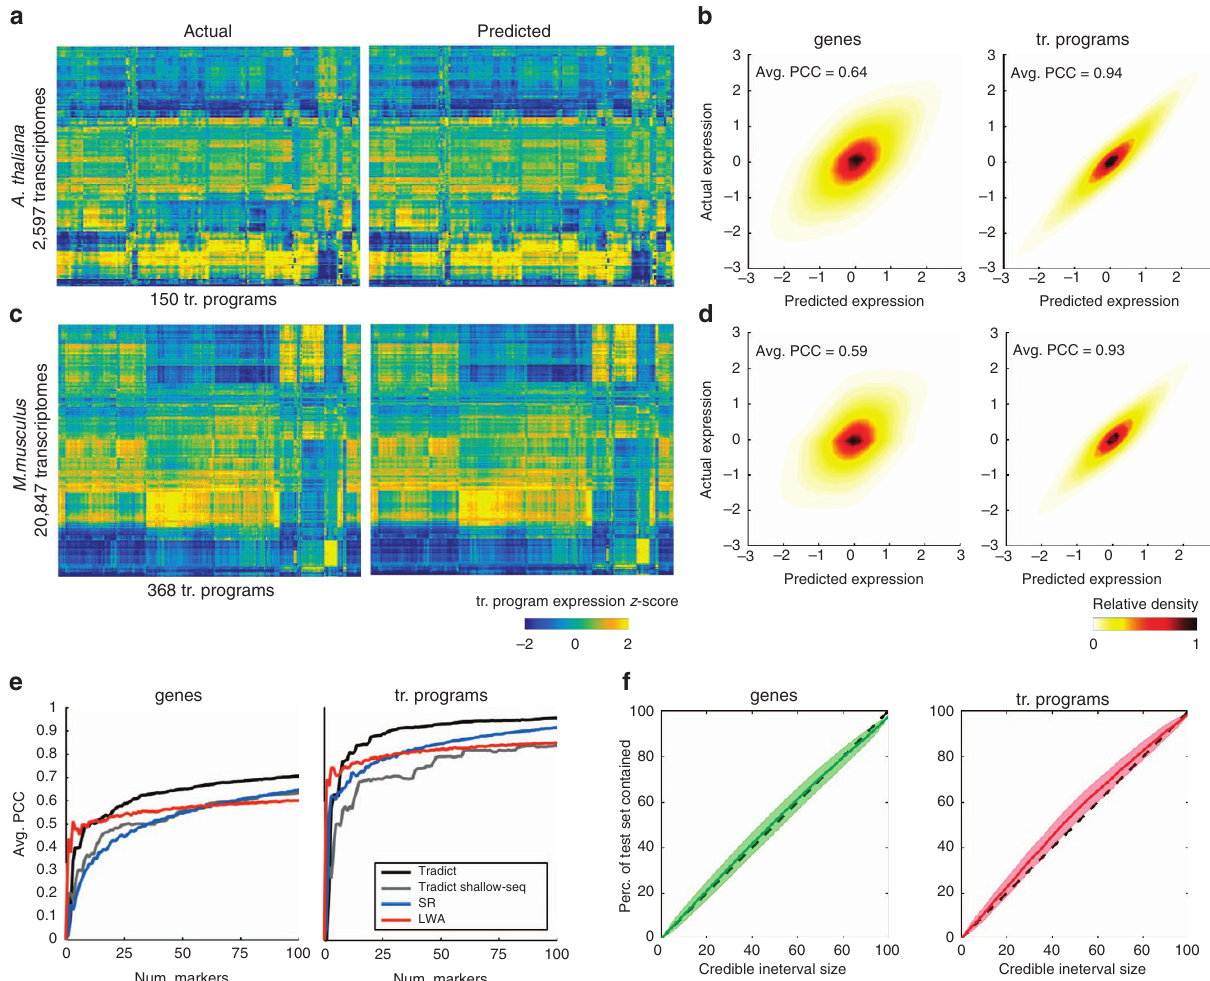
Figure 3 | Tradict prospectively predicts gene and transcriptional program expression with superior and robust accuracy. Tradict’s prospective prediction accuracy during 20-fold cross validation of the entire training collection for both organisms. ( a ) Heatmaps illustrating test-set reconstruction performance of all transcriptional programs for A. thaliana . Shown is the reconstruction performance for all samples in our transcriptome collection when they were in the test-set. ( b ) Density plots of predicted versus actual test-set expression for all genes (left) and transcriptional programs (right) for A. thaliana , after controlling for inter-sumbission biological signal. The intra-submission expression of each gene and transcriptional program was z -score transformed to make their expression comparable. ( c , d ) Same as ( a , b ), but for M. musculus . ( e ) Comparison of Tradict’s performance versus several baselines: SR, LWA and Tradict Shallow-Seq. ( f ) A posterior predictive check illustrating the concordance between Tradict’s posterior predictive distribution and the distribution of test-set expression values for genes (left) and transcriptional programs (right). Plotted is the percent of test-set observations contained within a credible interval versus the size of the credible interval. A unique credible interval is derived for each gene/program. The ‘x ¼ y’ line is illustrated as a dotted black line. Shaded error bands depict the sampling distribution of this analysis across test-sets from a 20-fold cross validation on the A. thaliana data